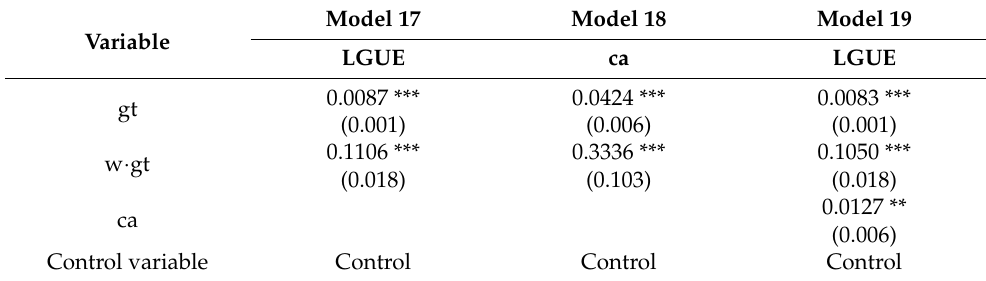
Table 9. Mechanism test results (Commercial activities).